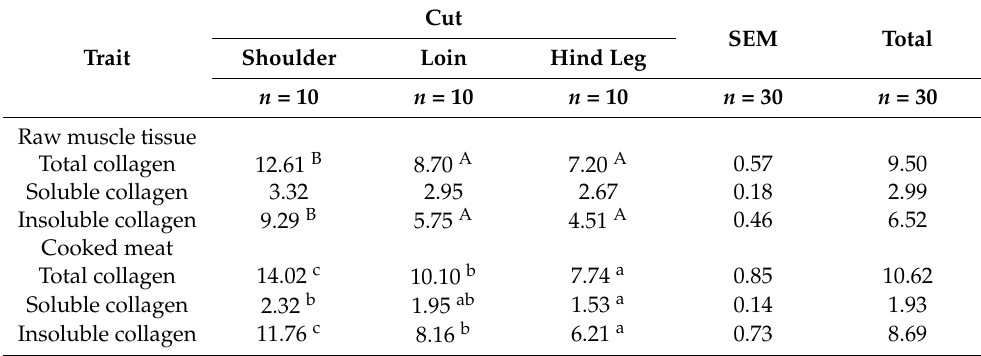
Table 2. Collagen fractions concentration (mg/g) in raw muscle tissue and cooked meat of beaver (mean ± standard error).